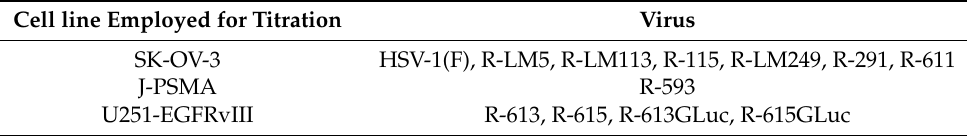
Table 3. Cell lines employed for titration of the viruses used in this